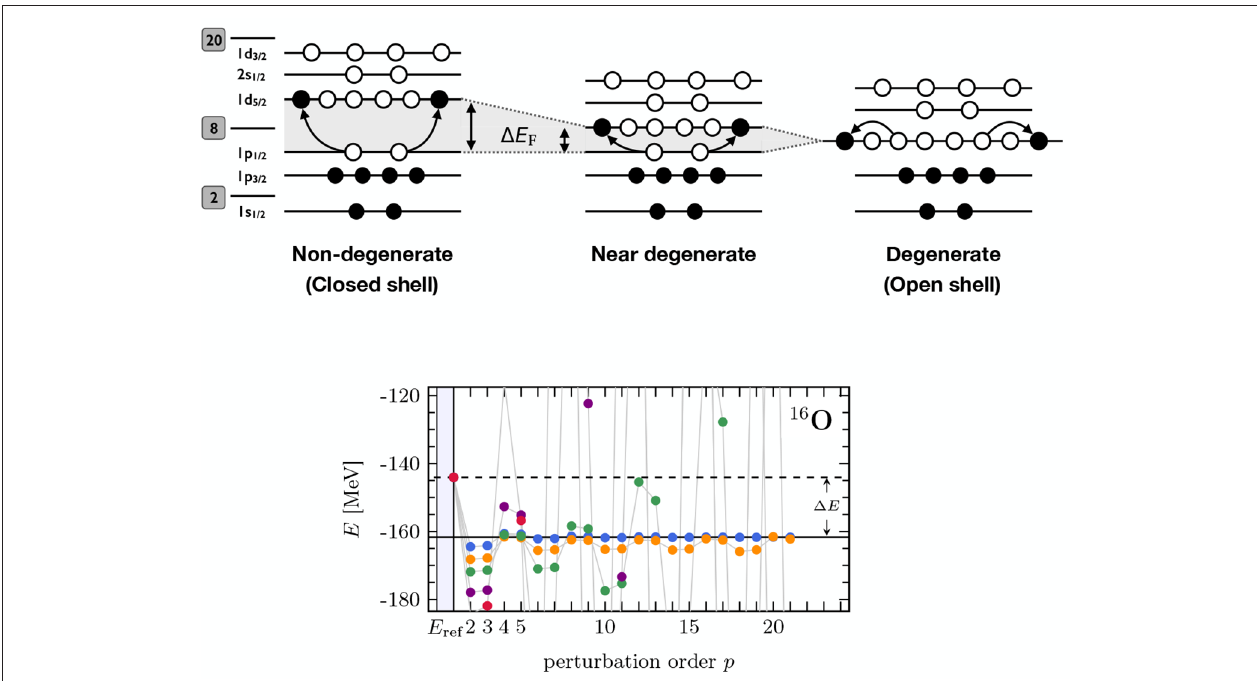
FIGURE 2 | (Top) Schematic representation of neutron or proton energy shells and associated occupations corresponding to a two-particle/two-hole excitation on top of the reference Slater determinant, i.e., the ground state of H 0 , appropriate to a 16 O-like nucleus (N = Z = 8). The last occupied shell in the reference state is the Fermi level and its energy separation to the first empty level is denoted as 1 E F . Left: closed-shell nucleus for which the number of nucleons is such that (i) the Fermi level is fully occupied and (ii) 1 E F ≫ 0. Center: sub-closed shell nucleus for which the number of nucleons is such that (i) the Fermi level is fully occupied and (ii) 1 E F is small. Right: open-shell nucleus for which the number of nucleons is such that the Fermi level is only partly occupied such that 1 E F = 0. (Bottom) Emergence of an infra-red divergence in the MBPT expansion of the ground-state energy of 16 O induced by a step-wise reduction (going from blue, to yellow, to green, to purple, and to red) of the size of the particle-hole gap in the spectrum of H 0